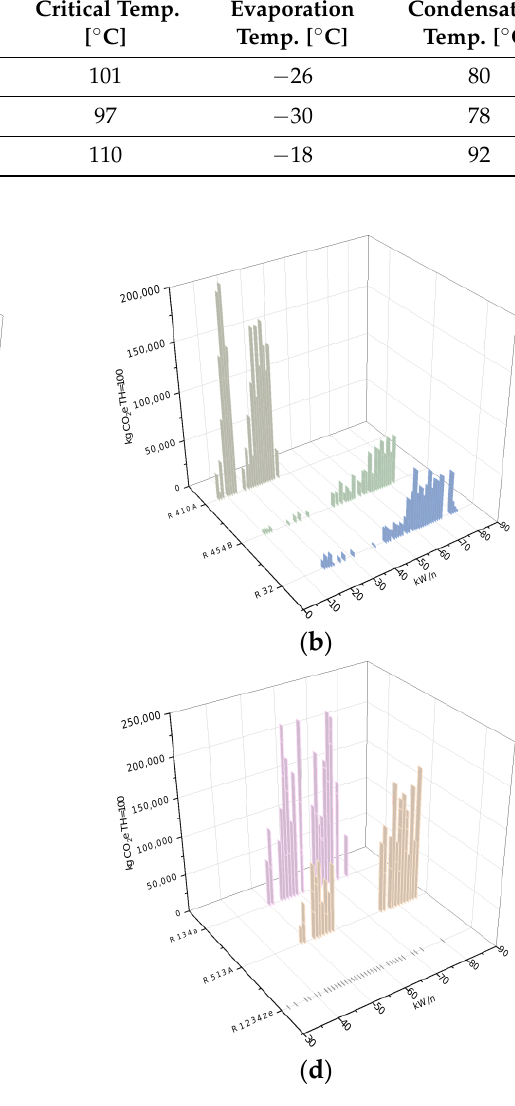
Figure 8. Equivalent of kg CO 2 e released to the atmosphere for selected refrigerants and their substitutes for: ( a ) R410A, TH = 20; ( b ) R410A TH = 100, ( c ) R134a TH = 20, ( d ) R134a TH = 100.